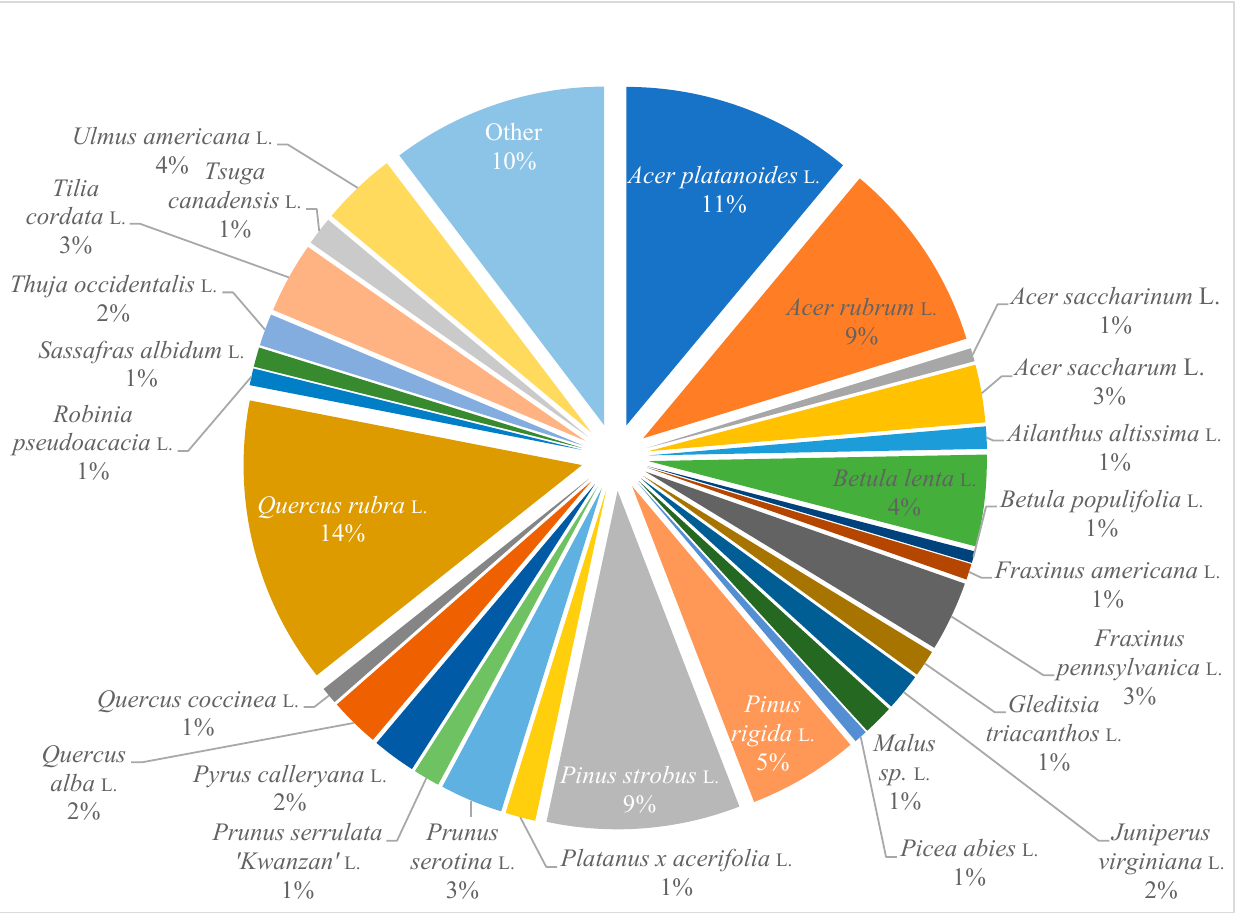
Figure 2. Species distribution of trees ( n = 2361); “other” included 244 individuals of 66 species or, for individuals that could not be identified to species, 10 genera each of which comprised <1% of the total sample.